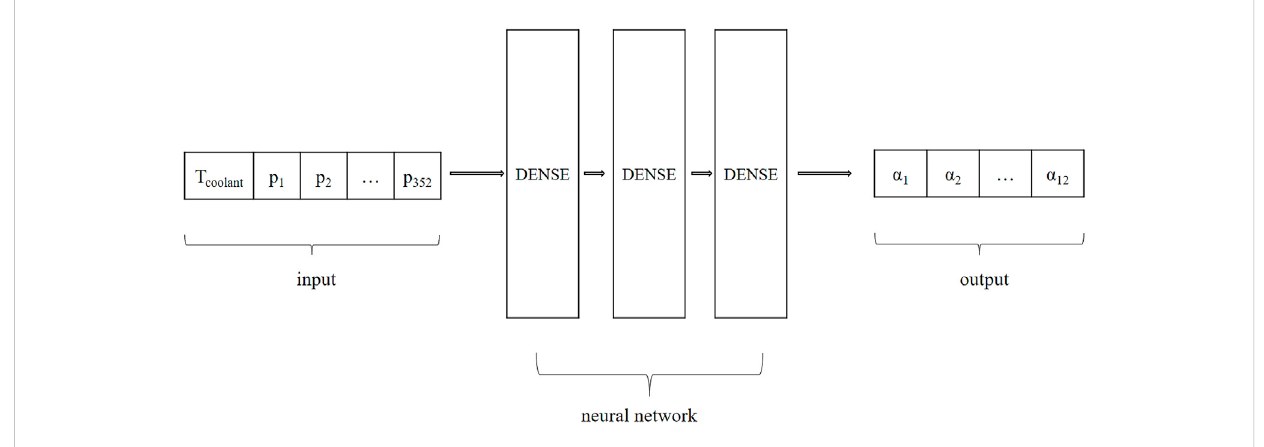
FIGURE 8 Neural network architecture for fuel rods zone.